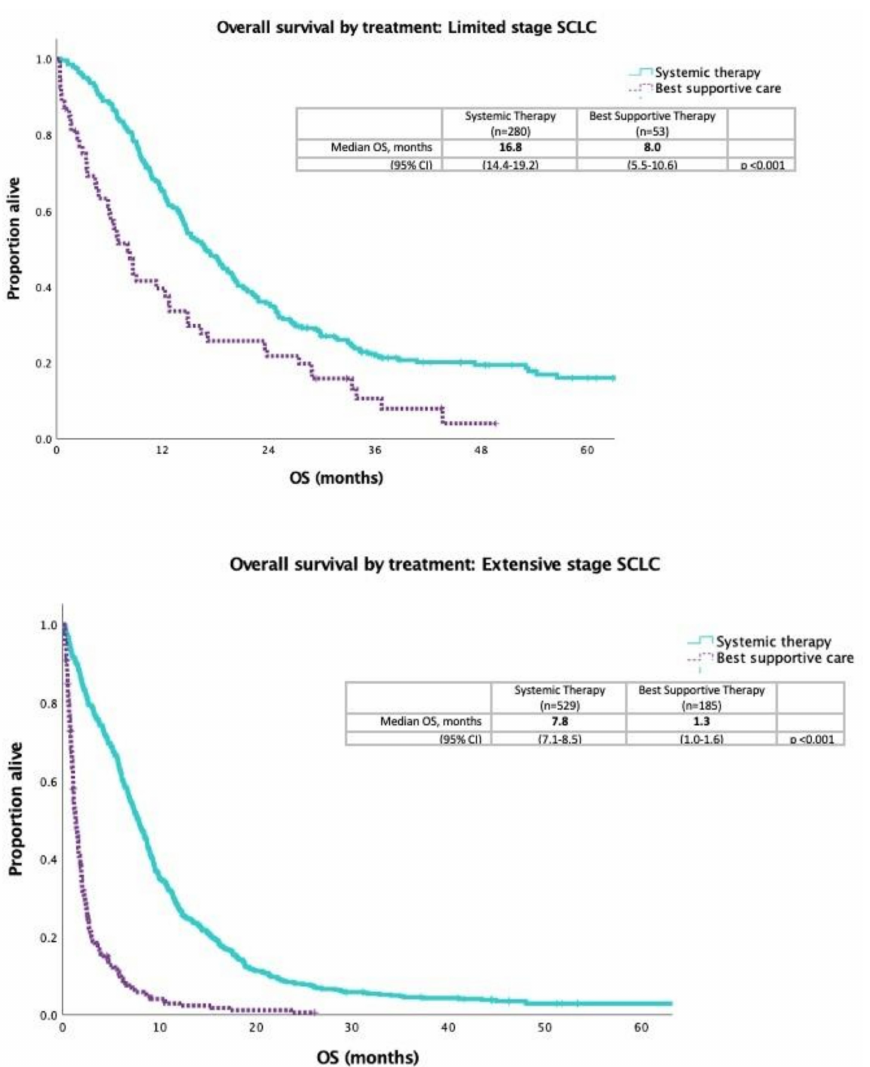
Figure 2. Kaplan–Meier curve for overall survival comparing patients who received systemic therapy to patients who received best supportive care in limited stage disease and extensive stage